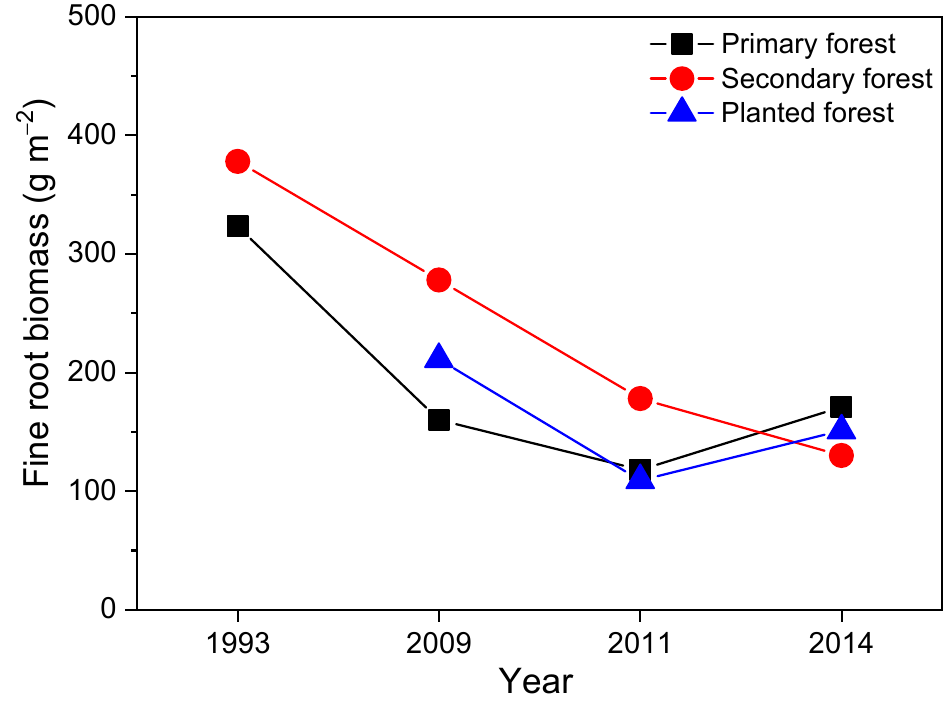
Figure 2. Fine root biomass in 1993 (Wen et al., 1999) [42], 2009, 2011, and 2014 at 0–10 cm mineral soil in the primary forest, the secondary forest, and the planted forest of Dinghushan Biosphere Reserve in southern China. Data for year 1993 were from Wen et al., (1999) [42]. Others were determined by authors.